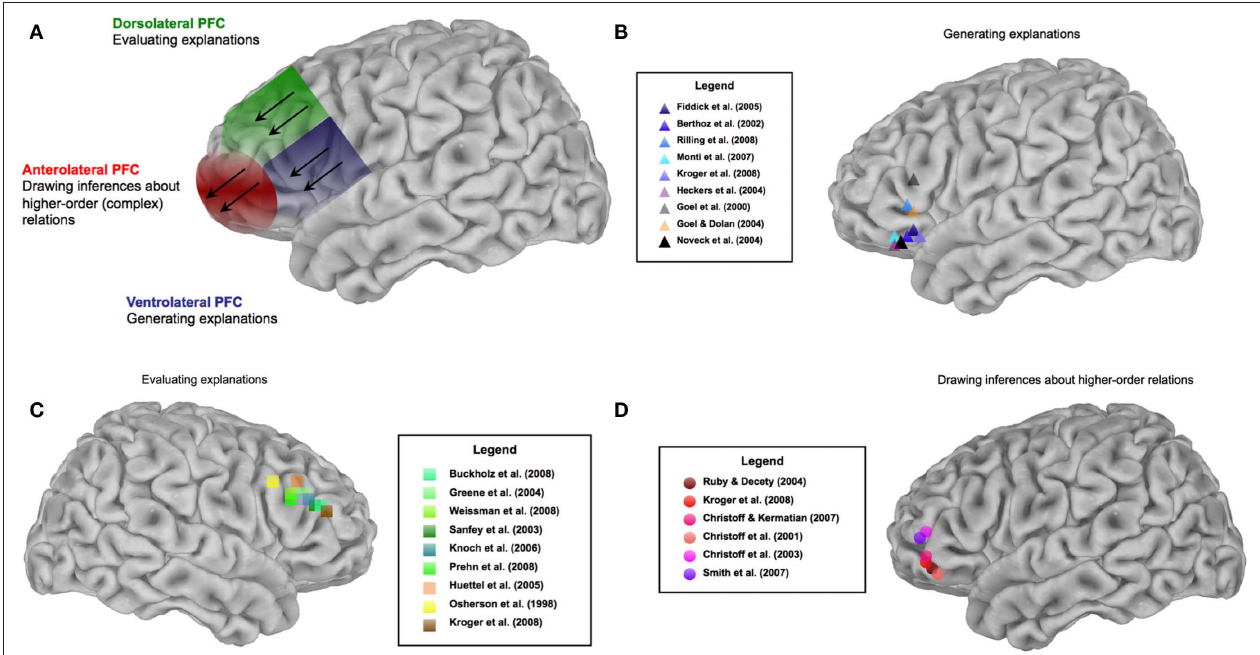
Figure 4 | Neural architecture of explanatory inference. (A) Summarizes the functional organization of the lateral PFC, and (B–D) illustrate